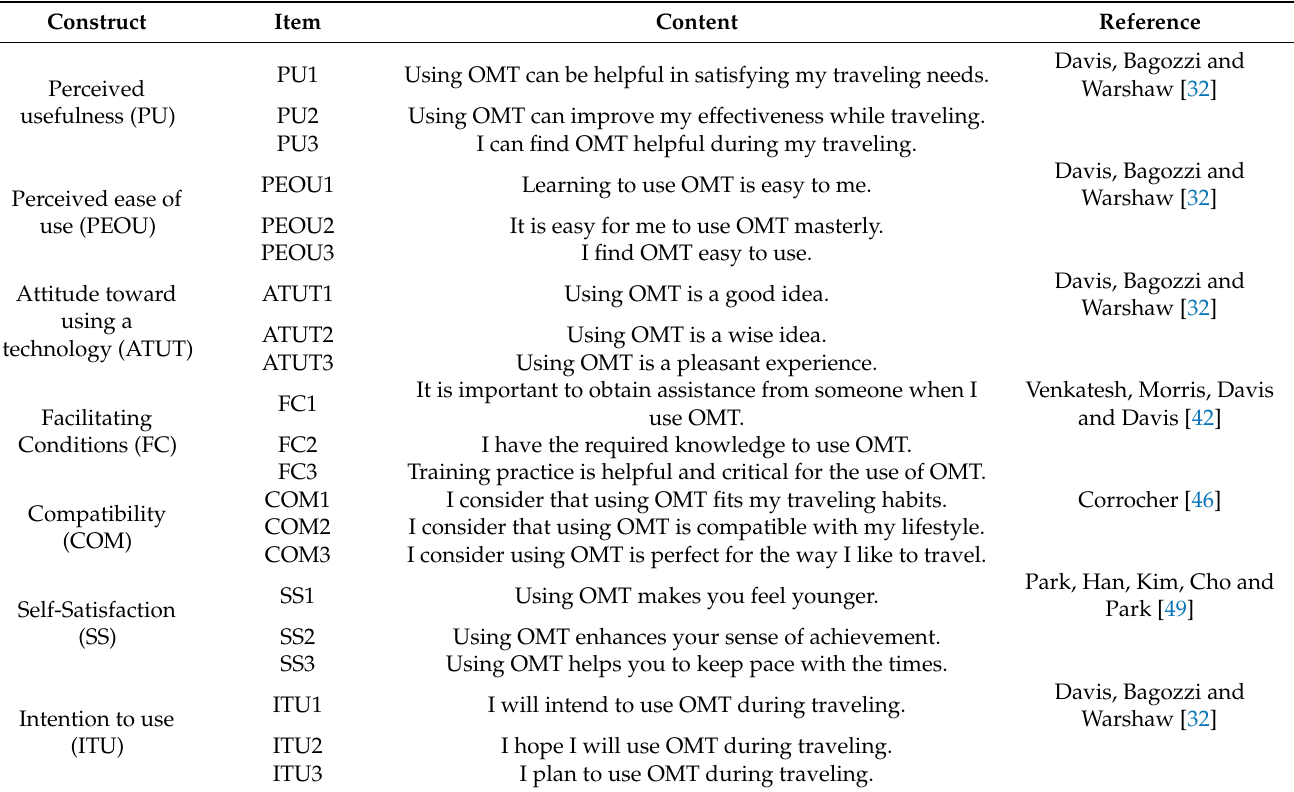
Table 1. Measurement items of this